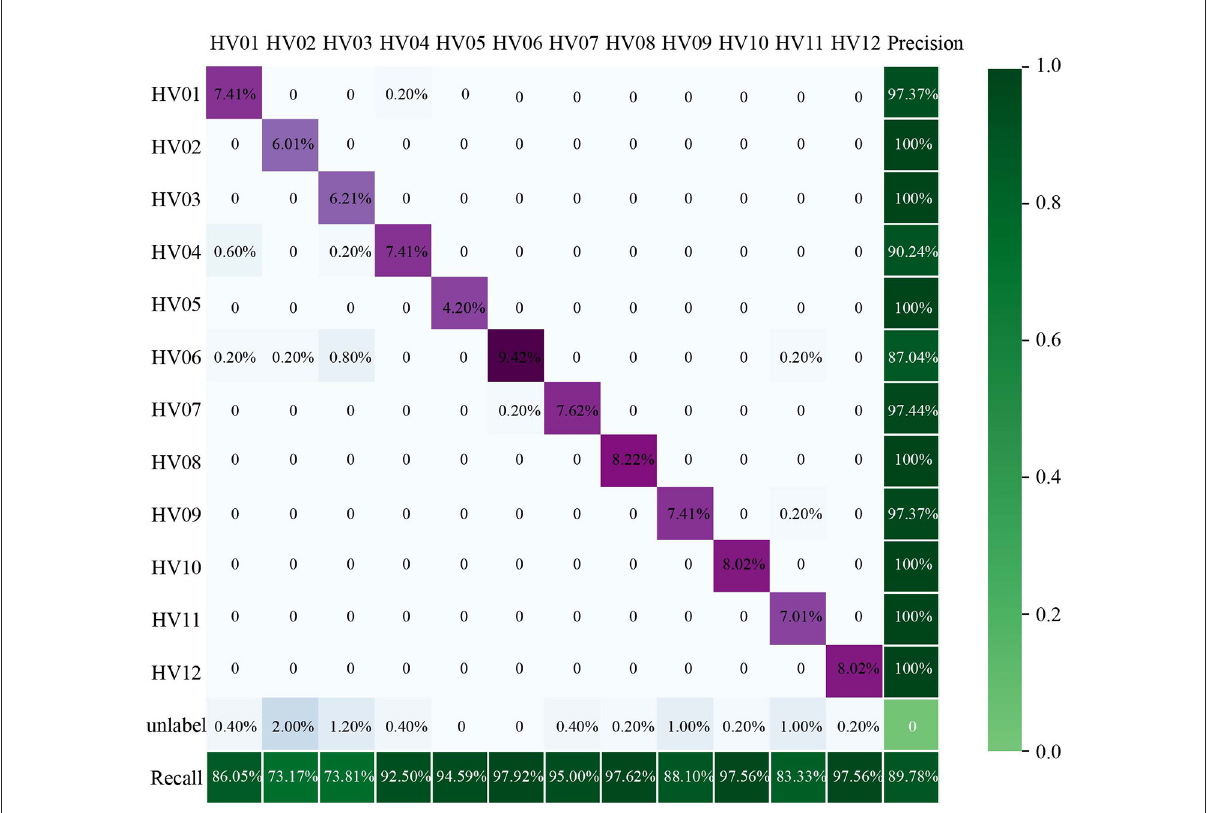
FIGURE11 The confusion matrix shows the result of using microbial fingerprints as features to classify individuals with a decision tree. The row and column in the confusion matrix represent the label identified by the decision tree and the authentic label of samples, respectively. The sum of each column is the actual number of samples of this individual. The purple blocks on the diagonal represent the samples that have been correctly classified. The last row and the last column in the matrix are the recall and precision, respectively. Darker color correlates with higher accuracy of the